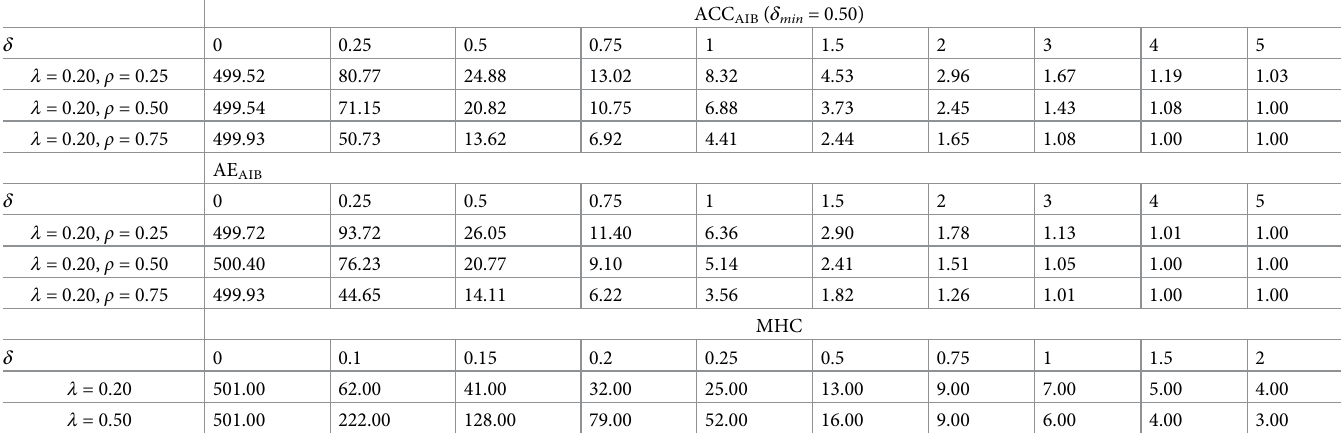
Table 6. The run length profile ACC AIB , AE AIB , and MHC control charts at ARL 0 = 500.